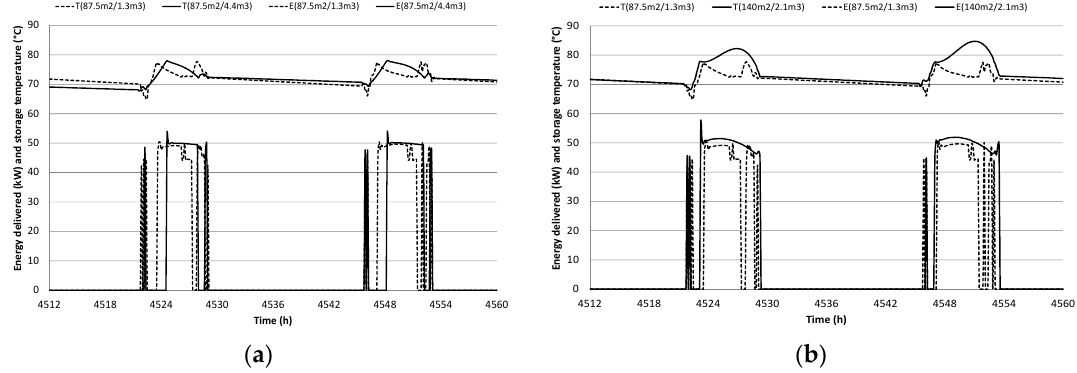
Figure 6. Effect of the specific collector field surface and storage volume on the energy supplied to the absorption chiller ( a ) 87.5 m 2 -1313 L and 87.5 m 2 -4375 L ( b ) 87.5 m 2 -1313 L and 140 m 2 -2100 L. (Driving temperature of 75 °C).